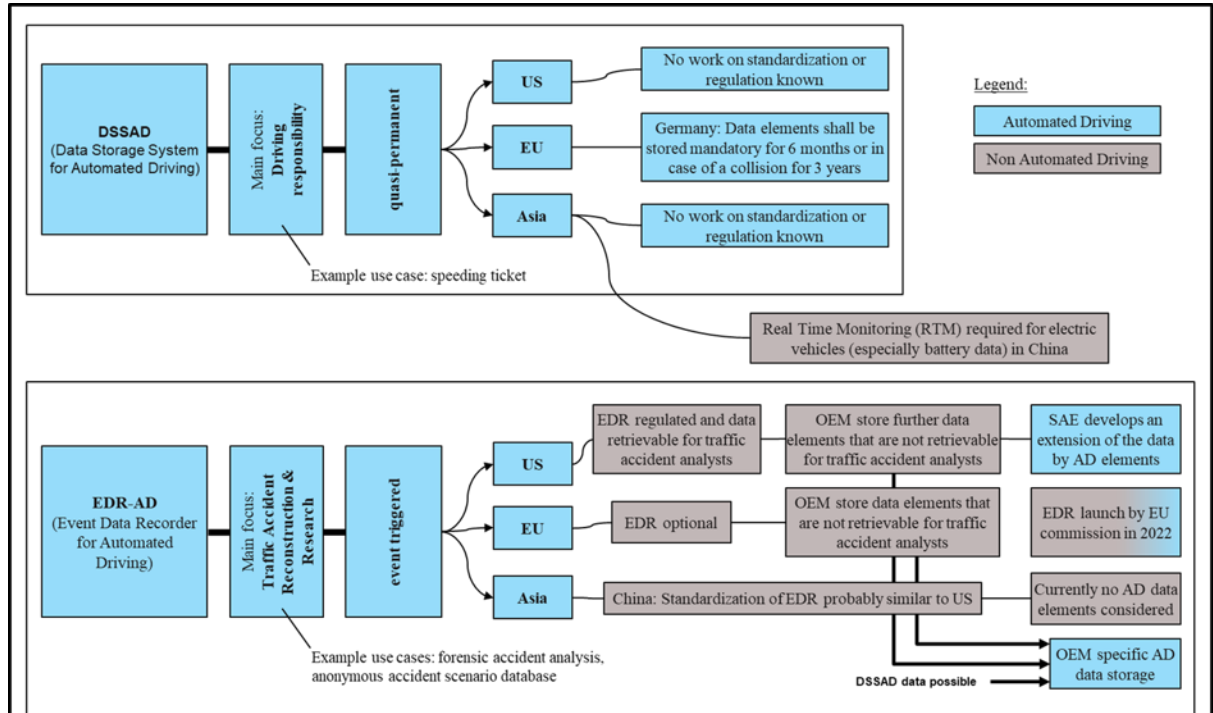
Figure 1: Overview of international regulations regarding EDR and DSSAD. Sources: [2, 3].